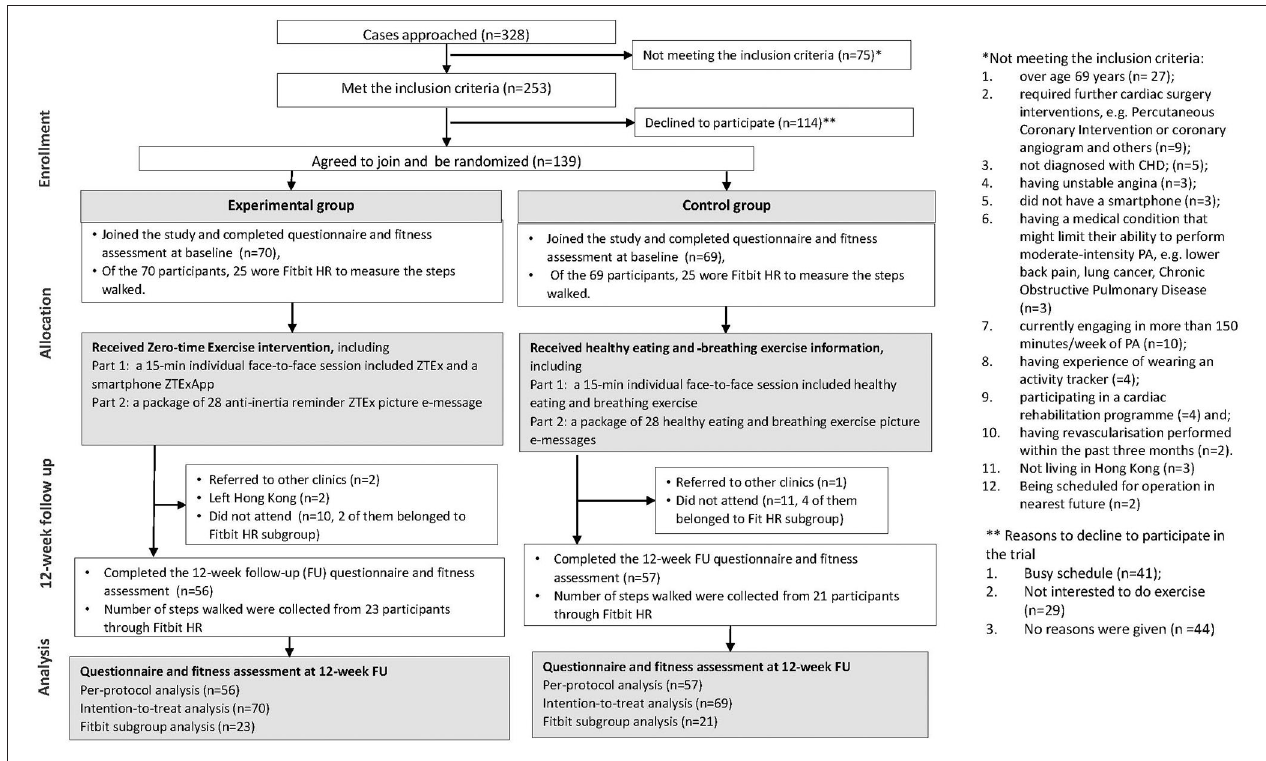
FIGURE 1 | The flow of participants (The CONSORT